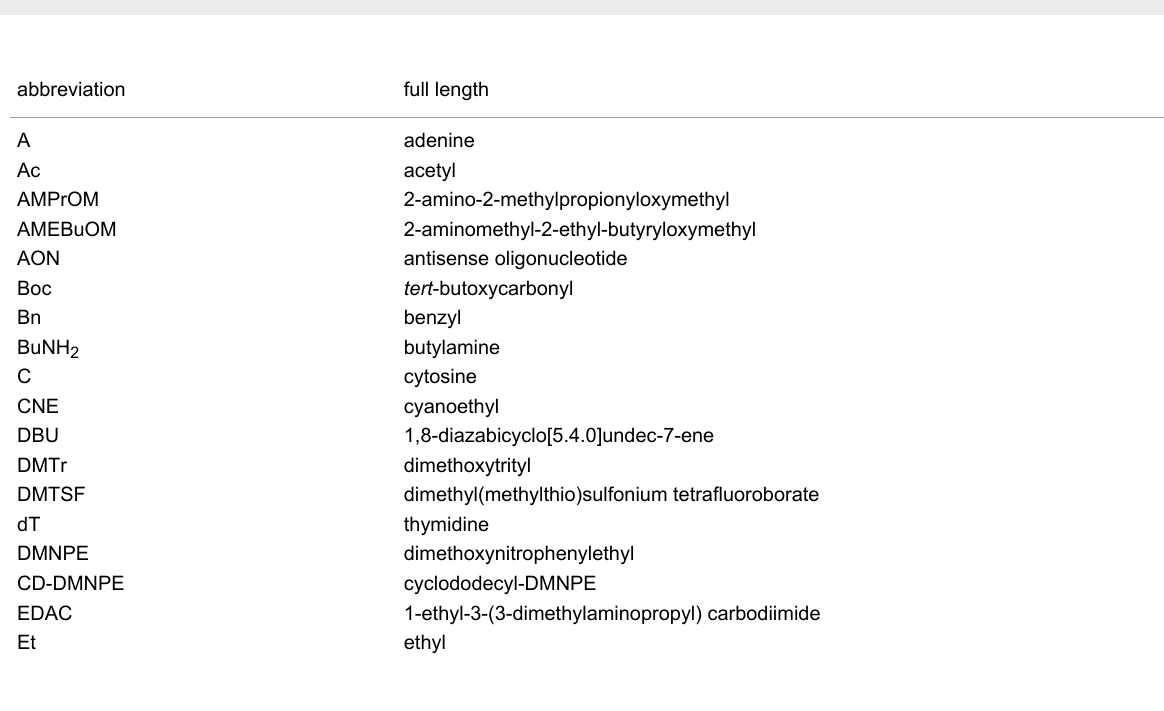
Table 1: List of